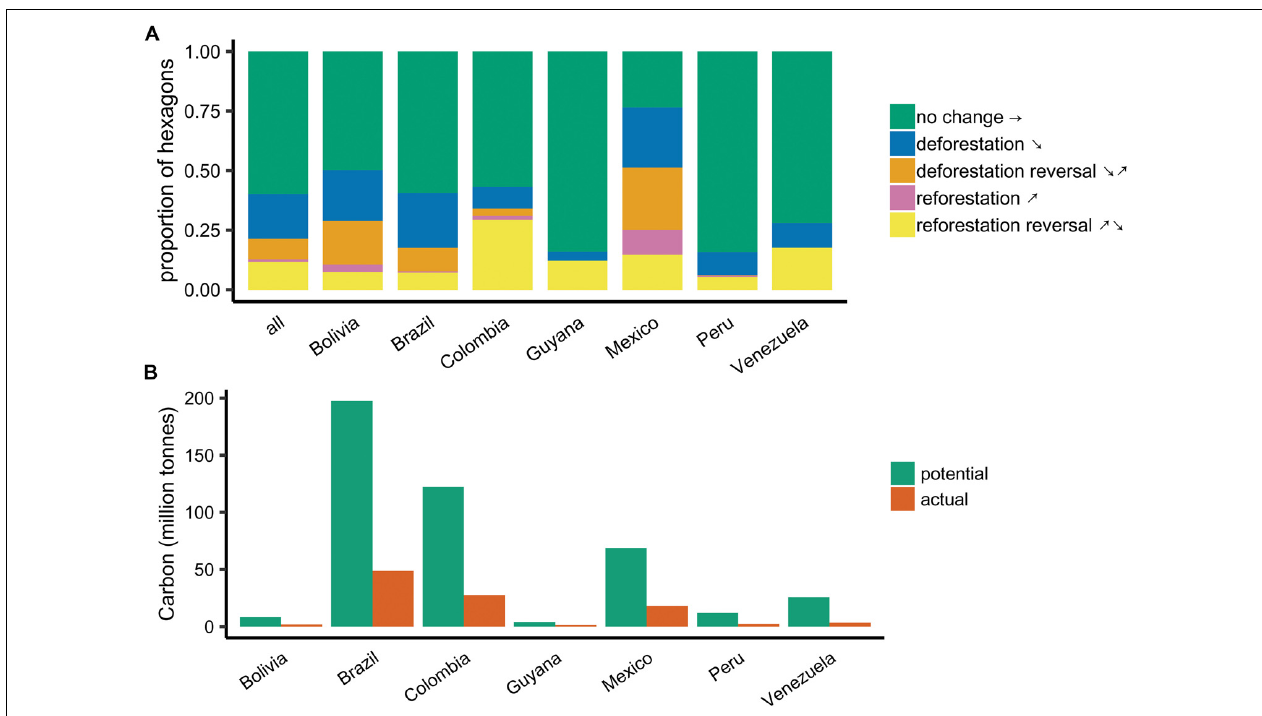
FIGURE 2 | (A) Relative proportions of hexagon forest cover change trajectories across countries and biomes. Seven countries with the largest amount of tropical forest area are shown; see Supplementary Table S1 for data on additional countries. Hexagons that could not be assigned a trajectory with high confidence are omitted. (B) Comparison of carbon sequestration potential without reforestation reversal and estimated actual carbon uptake in seven LAC countries with most tropical forest